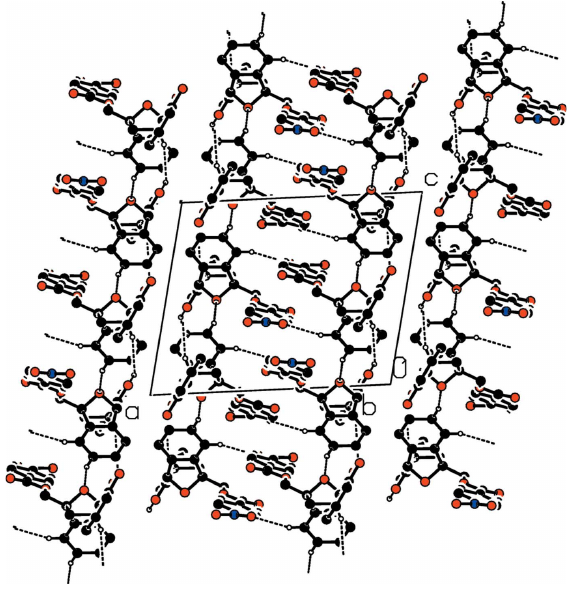
Figure 3 Part of the crystal structure with weak hydrogen bonds shown as dashed lines. Only H atoms involved in hydrogen bonds are shown.